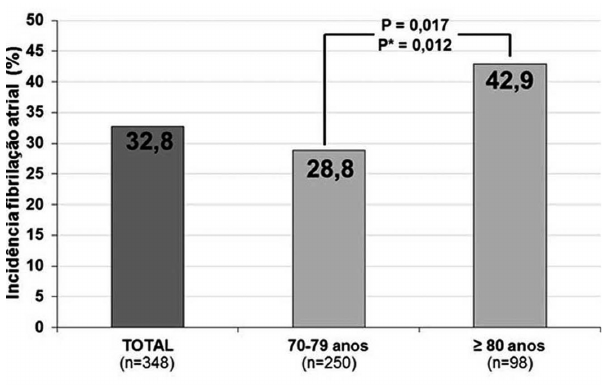
Fig. 1 – Incidence of postoperative atrial fibrilation after aortic stenosis surgery, total and according to age. *Adjusted for chronic obstructive pulmonary disease, previous smoking, peripheral vascular disease, and LVEF < 40% . Incidência fibrilação atrial = Incidence of atrial fibrillation; total = total; anos =